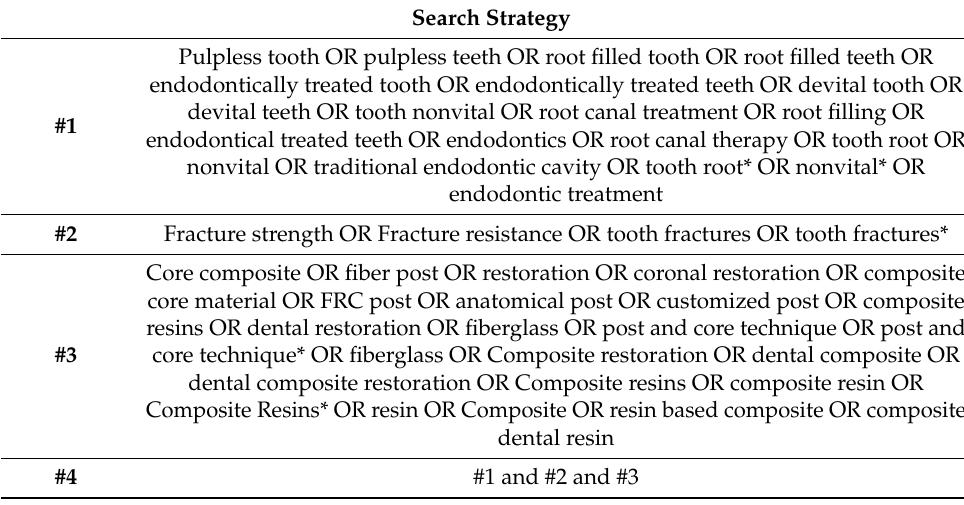
Table 1. Keywords and search strategy used in PubMed.